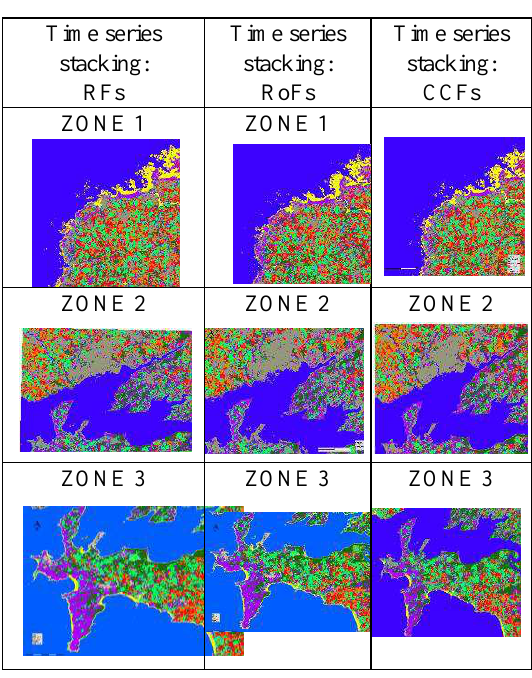
Figure 3. Machine Learning Models with stacking of Sentinel-1 and Sentinel-2